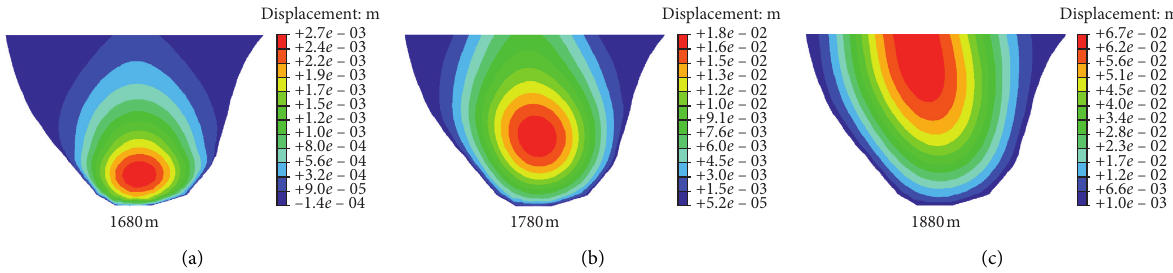
Figure 8: Radial displacement simulated by finite element method under varying upstream water levels: (a) 1700m; (b) 1780m; and (c) 1880m.